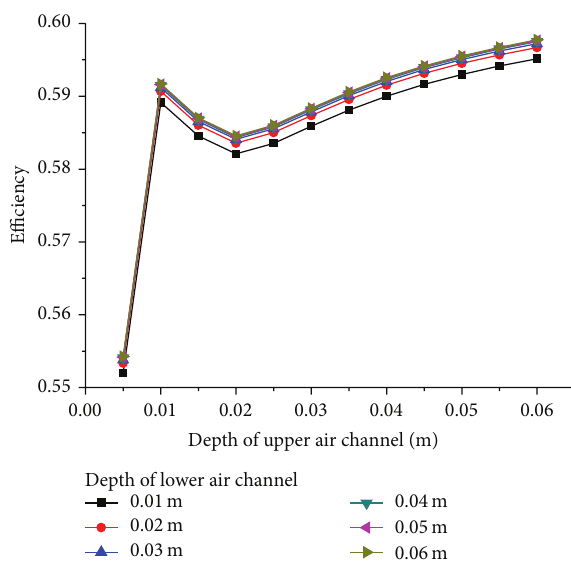
Figure 11: Effect of depths of air channels on efficiency of the collector in water heating mode (0.015 m thick insulation).